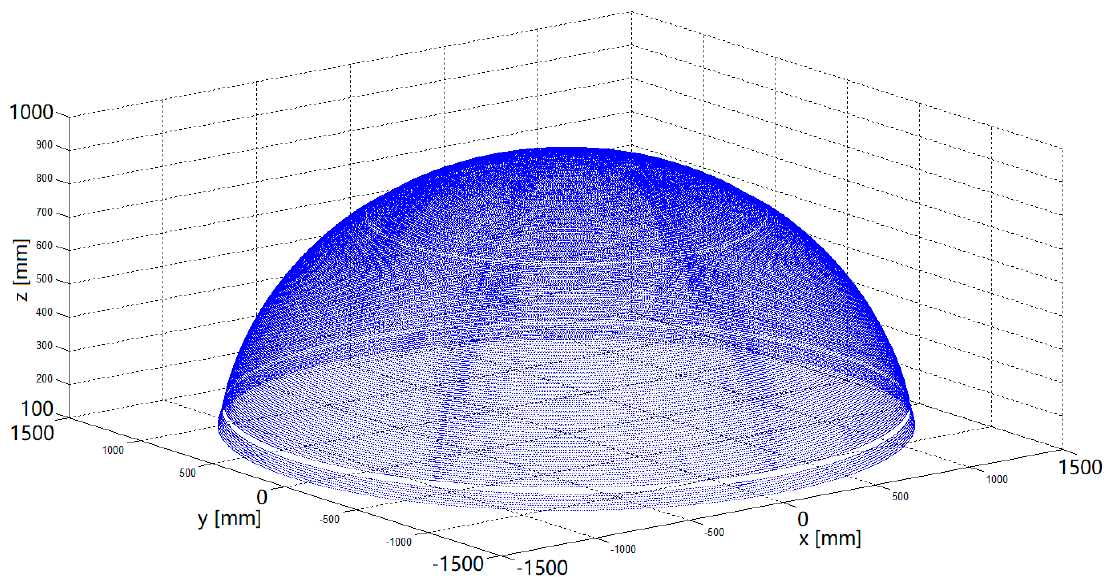
Figure 6. Spatial distribution of initial point cloud data.